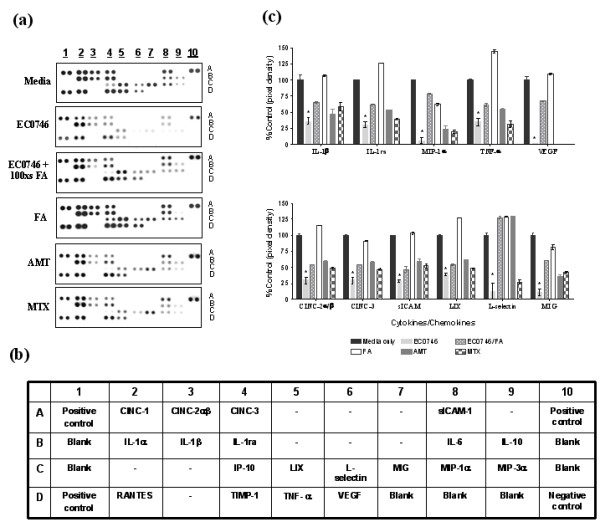
EC0746 has an immunomodulatory effect on folate-receptor-expressing rat TG-macs. Rat TG-macs were treated with media only, 100 nM EC0746 ± 10 μM folic acid (FA), or FA alone (10 μM) for 2 hours followed by a 70-hour chase. In comparison, the cells were also treated with 100 nM free aminopterin (AMT) and methotrexate (MTX) for 72 hours. At 24 hours before the end of incubation, all cells were stimulated with lipopolysaccharide (LPS) (5 μg/ml) plus IFNγ (100 ng/ml). The cytokines/chemokines produced in culture supernatants were detected using a rat cytokine array. (a) Cytokine release profiles of rat TG-macs stimulated with LPS and IFNγ with or without drug treatment. (b) Cytokine array map. (c) Mean pixel intensity (y axis) determined for each array position and plotted for the 11 products, which were detected at three times above background levels and in at least three independent experiments. Data shown are mean ± standard error of the mean. *P < 0.05 when compared with its corresponding cytokine level in the media only sample. CINC, cytokine-induced neutrophil chemoattractant; LIX, LPS-induced CXC chemokine; MIG, monokine induced by IFNγ; MIP-1α, macrophage inflammatory protein-1α; RANTES, regulated upon activation, normal T-cell expressed and secreted; sICAM, soluble intracellular adhesion molecule; TIMP-1, tissue inhibitor of metalloproteinase 1; VEGF, vascular endothelial growth factor.